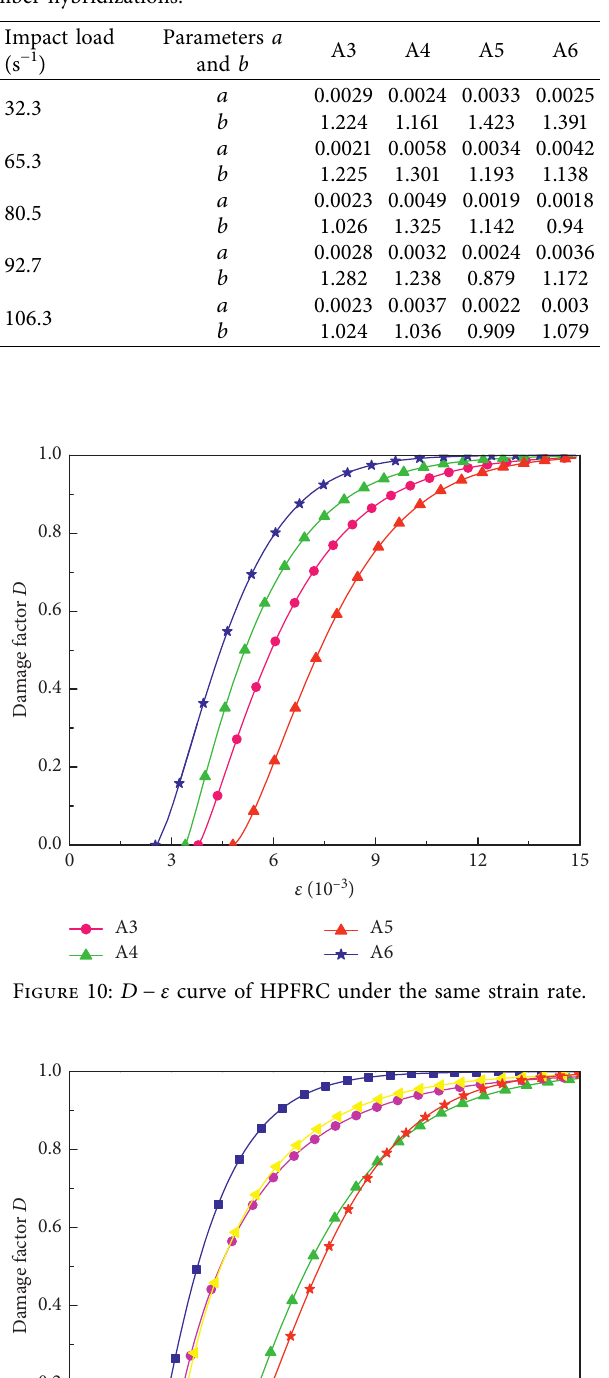
Table 6: The fitting value of parameters a and b under different fiber hybridizations.